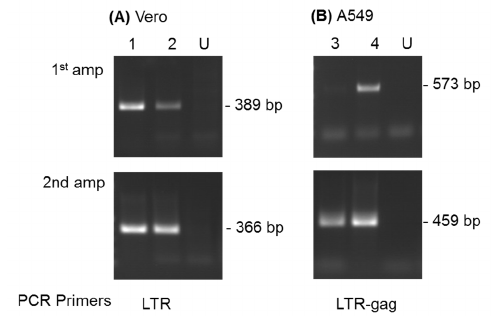
Figure 3. Detection of SFV sequences by DNA PCR analysis. DNA prepared at day 34 from SFVmcy_FV21- and SFVmcy_FV34[RF]-inoculated Vero cells (panel A , lanes 1 and 2, respectively) was analyzed using LTR primer sets (outer for 1st amplification and inner for second amplification). DNAs prepared from SFVcae-FV2014-inoculated A549 cells at day 34 and day 55 (panel B ; lanes 3 and 4, respectively) were analyzed using LTR-gag outer and inner primer sets. DNA from uninoculated cells was obtained from each cell line (day 34) and included as negative control (lanes